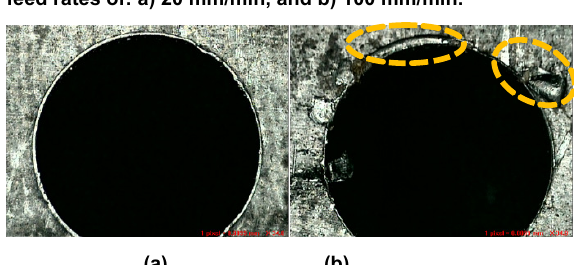
Figure 17.VMM images of holes “entrance” surface in CD at feed rates of: a) 20 mm/min, and b) 100 mm/min.